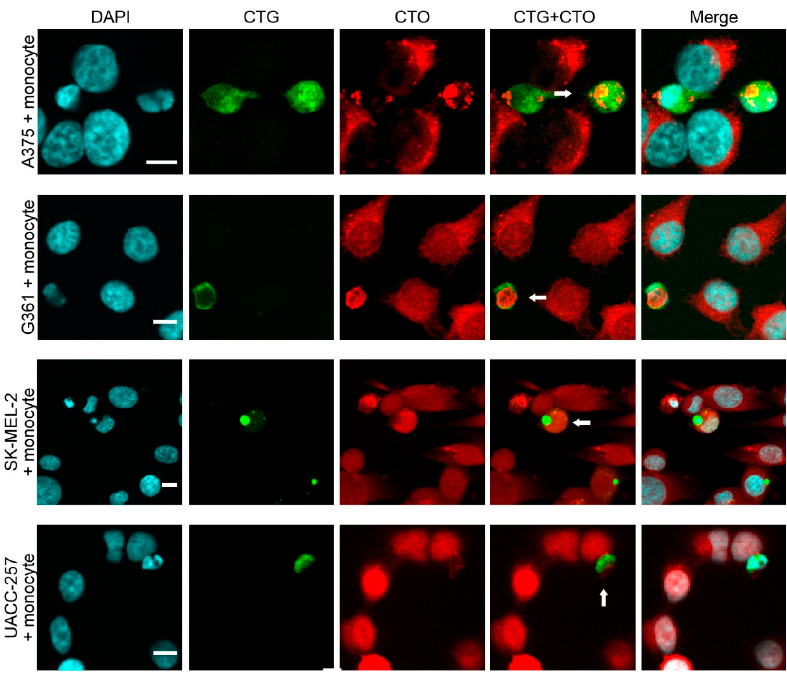
Figure 4. Melanoma–fibroblast and melanoma–monocyte hybrids are indistinguishable from stromal cells based on cell morphology. Spontaneously formed melanoma (CTO)–monocyte (CTG) hybrids (white arrows) from different melanoma cell lines adopt the morphology of monocytes. White bars indicate 10 µm.